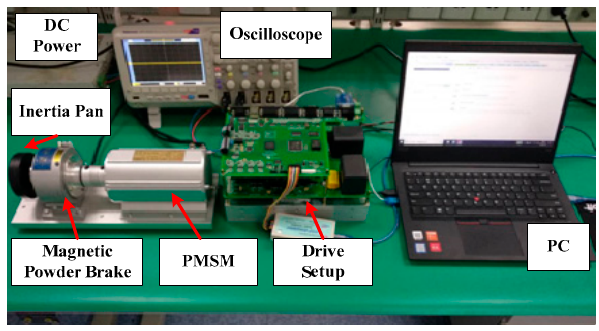
Figure 11. Image of the experimental platform.